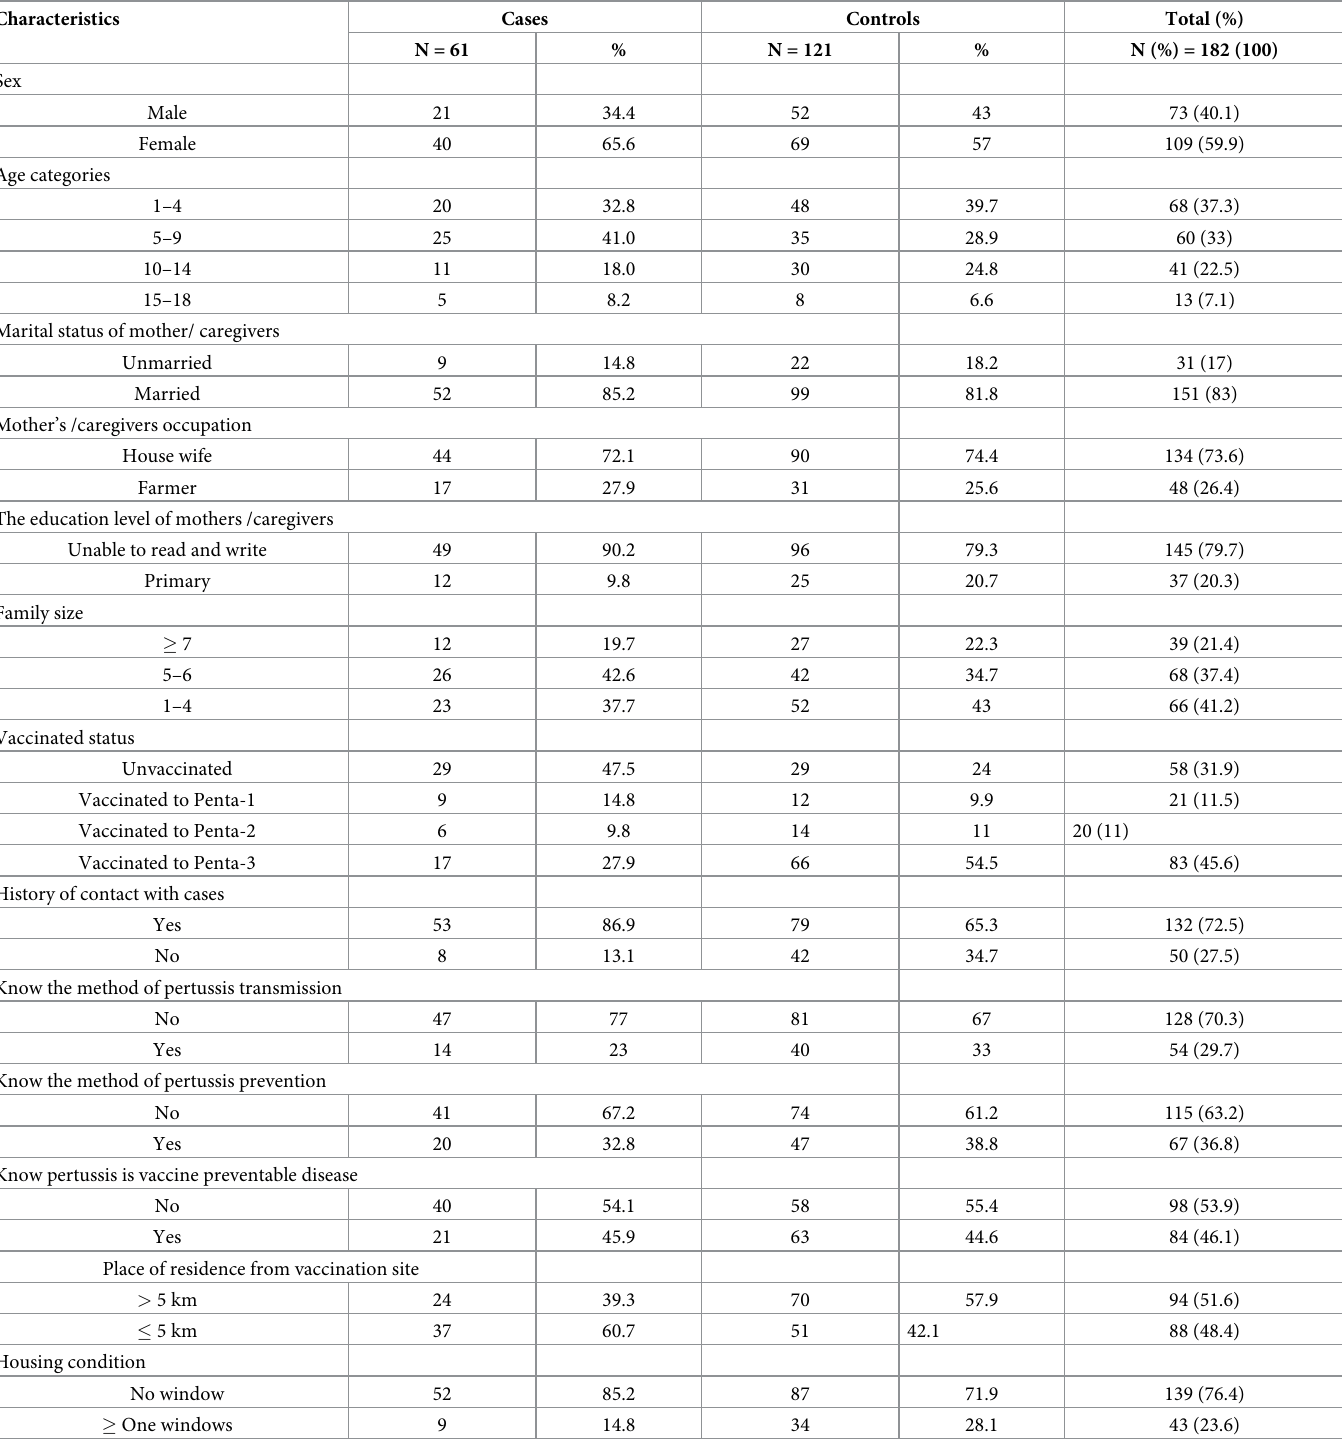
Table 3. Characteristics of pertussis cases and controls in Azila cluster of Dahena district, April 2019.